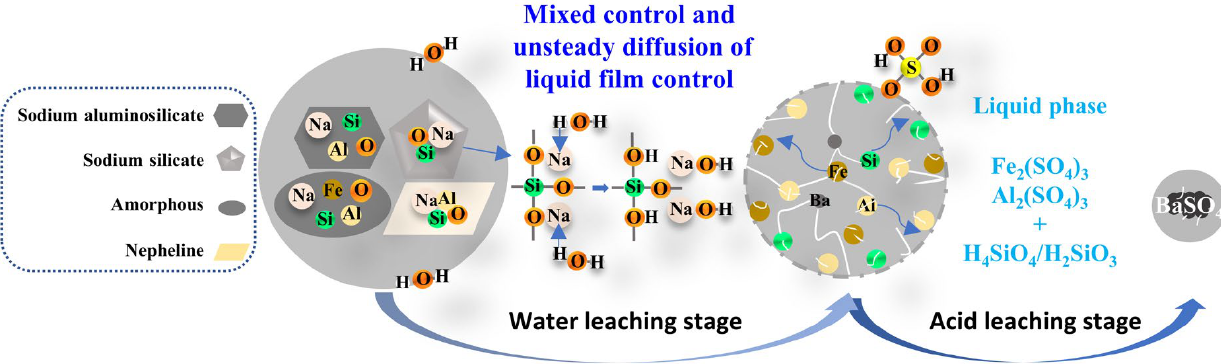
Figure 15. Schematic of the mechanism of the water–acid leaching of silicon, aluminum and iron from the silver tailing roasted clinker.